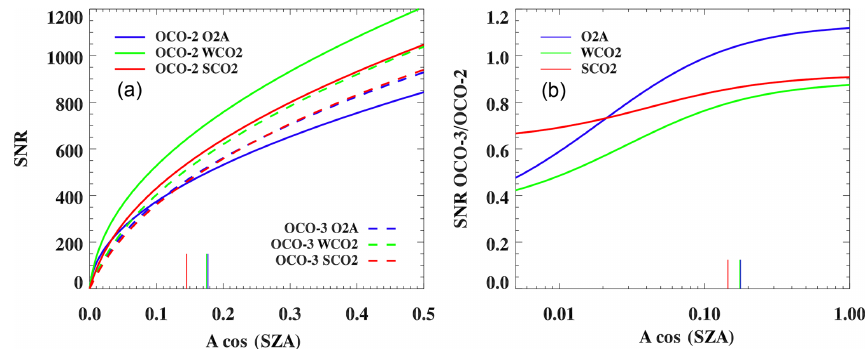
Figure 7. OCO-2 and OCO-3 mean SNR (averaged across footprints and channels) for each band as a function of the product of surface albedo and cosine of solar zenith angle (a) . The quantity A cos ( SZA ) is proportional to the reflected sunlight off a surface. Panel (b) shows the ratio of OCO-3 SNR to OCO-2 SNR using a logarithmic abscissa scale. The small vertical lines represent A cos ( SZA ) for Railroad Valley at the winter solstice. OCO-3 SNR is lower at lower signal levels because it has a higher noise floor than OCO-2.